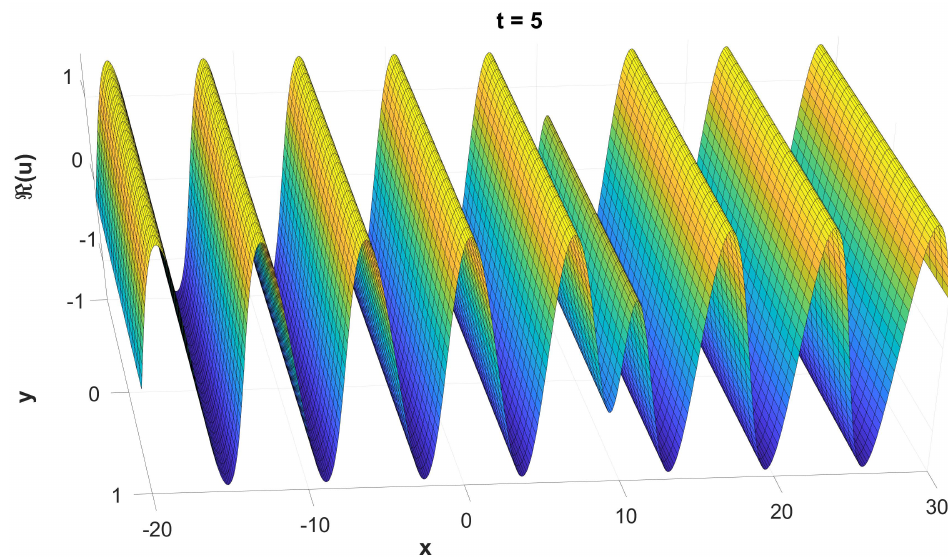
(cid:12) 2 , evaluated numerically. (cid:12)